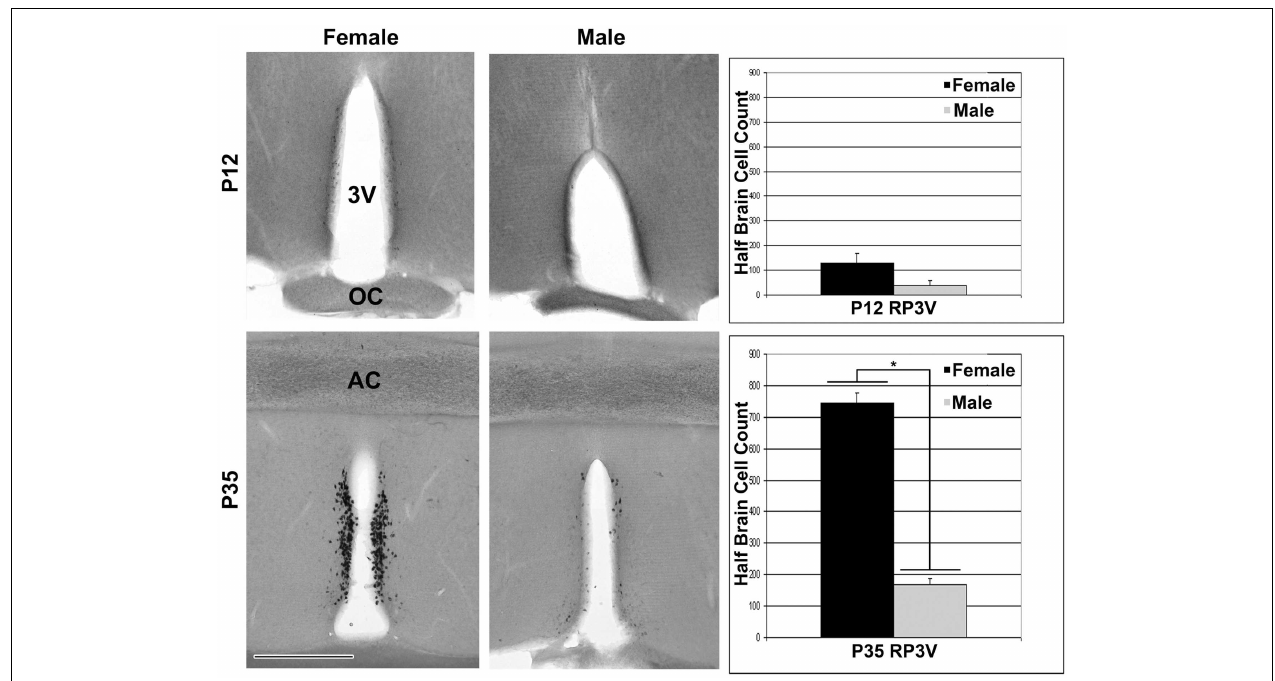
the time of puberty onset in females, P35 (see graphs on the right; n = 3 per group; mean ± SEM; * p < 0.01). 3V, third ventricle; OC, optic chiasm, AC, anterior commissure; Scale bar = 500 µ m.